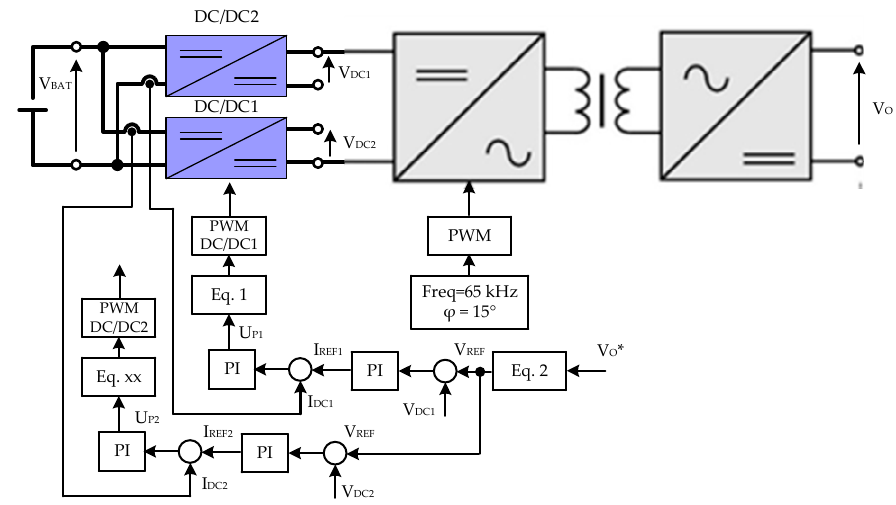
Figure 8. Block scheme of the digital control system.